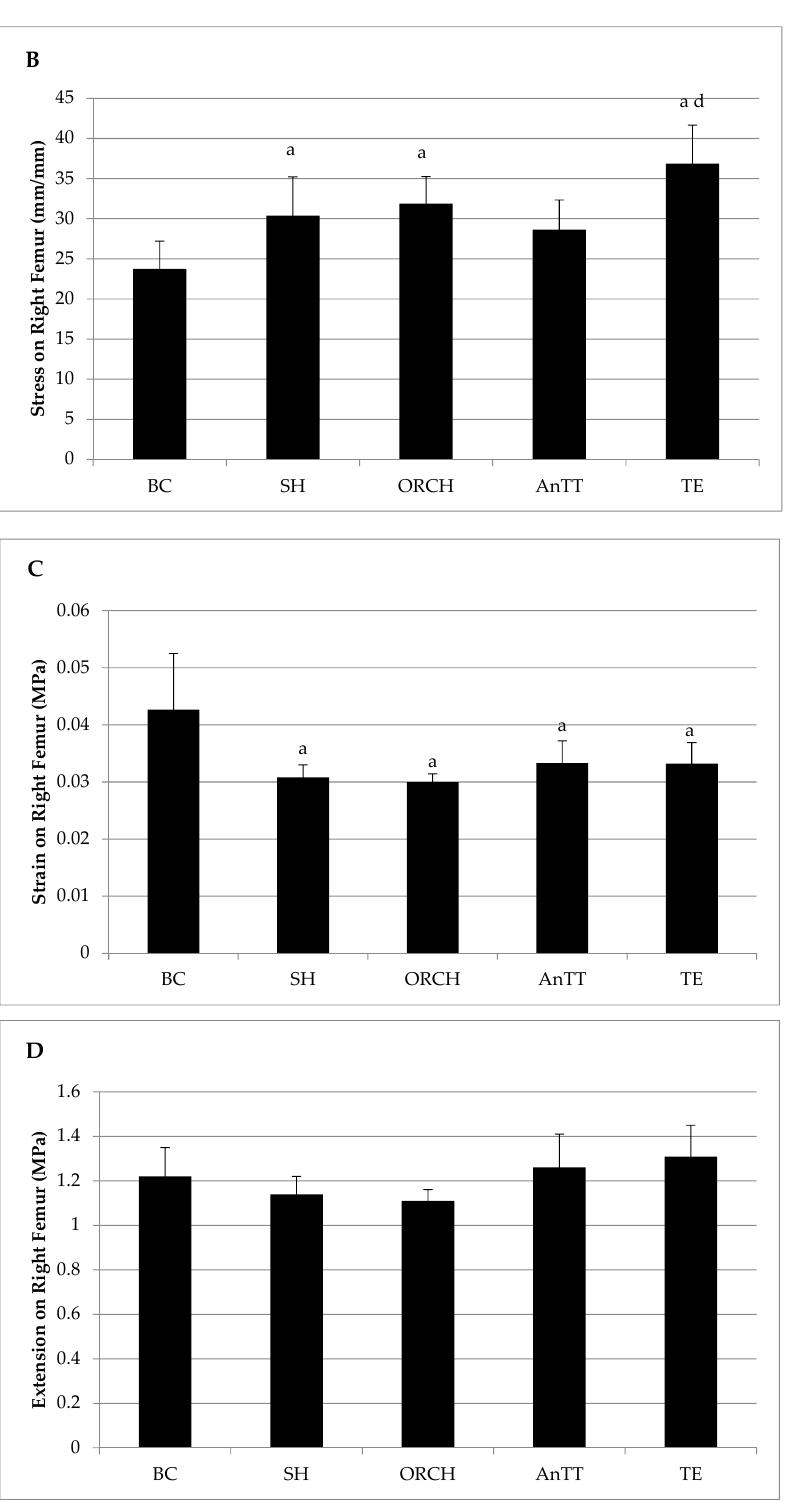
Figure 5. Post-treatment bone biomechanical strength parameters of the right femur, i.e., load ( A ); stress ( B ); strain ( C ) and extension ( D ). The data are shown as mean with standard error of the mean. Letter ‘a’ indicates significant difference versus the baseline group; ‘d’ versus the annatto tocotrienol-supplemented group. Abbreviation: AnTT, annatto tocotrienol-supplemented group; BC, baseline control group; ORCH, orchidectomized group; SH, sham-operated; TE, testosterone enanthate-supplemented